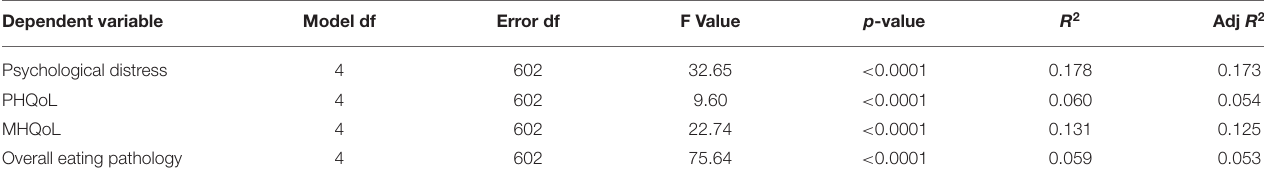
TABLE 3A | Overall F test and fit statistics of the models with defence style and demographic factors predicting psychological distress, PHQoL, MHQoL, and overall eating pathology. Dependent variable